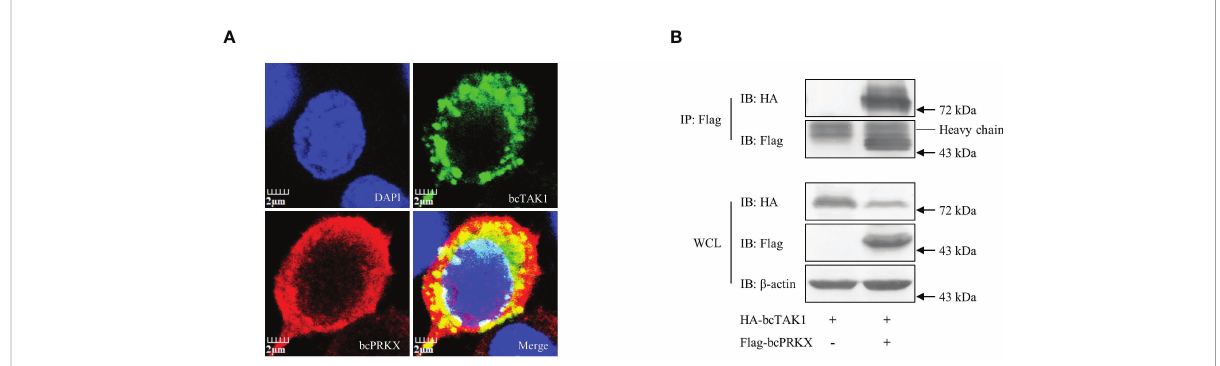
FIGURE 8 The interaction between bcPRKX and bcTAK1. (A) EPC cells were co-transfected with Flag-bcPRKX and HA-bcTAK1 and the cells were fi xed for immuno fl uorescence microscopy at 24 h post-transfection according to the methods. The scale bar represented 2 m m. (B) HEK 293T cells in a 10 cm diameter petri dish were co-transfected with bcPRKX and/or bcTAK1 separately. The cells were harvested for immunoprecipitation (IP) assay and subsequential immunoblot (IB) assay at 48 h post-transfection according to the